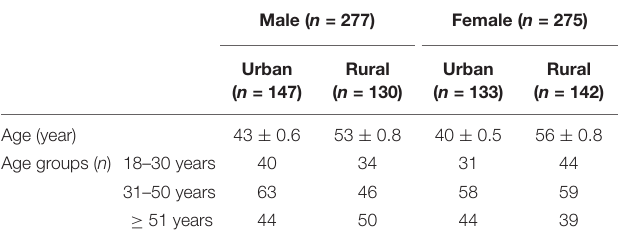
TABLE 1 | Characteristics of